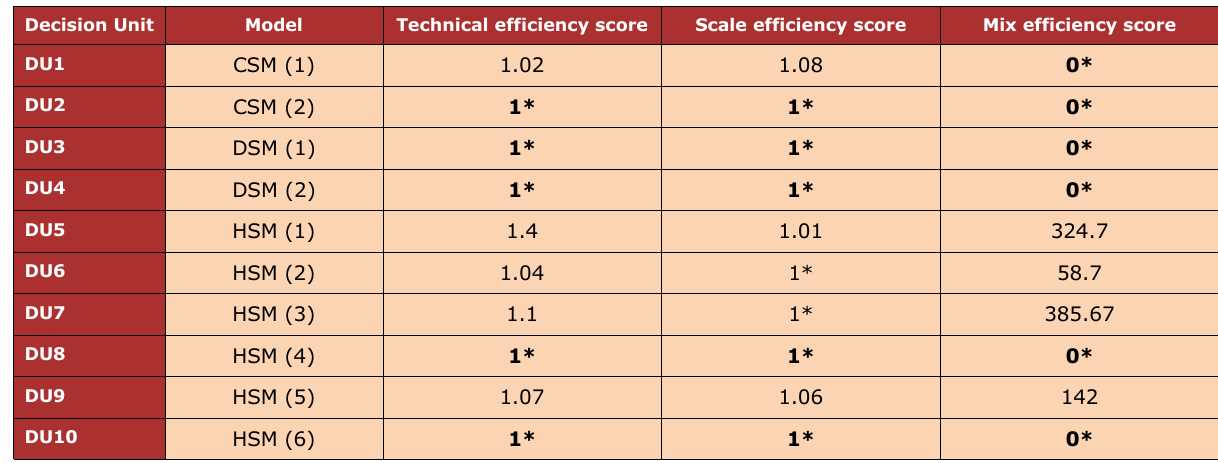
Table 15. Inefficiency terms for the setting with low